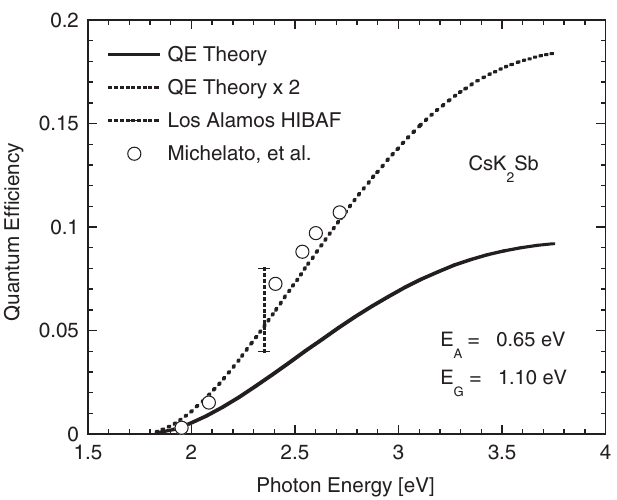
FIG. 4. Comparison of experimentally measured values of the quantum efficiency of CsK Sb photocathodes based on 2 Refs. [50] (circles) and [1] (dashed line) compared to the theoretical model, from which an operational value for the electron affinity is deduced to be 0.65